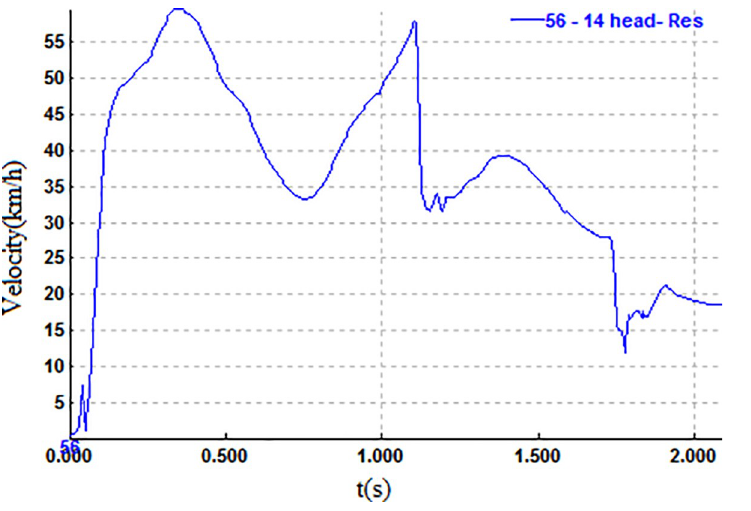
Fig 7. Speed curve of the pedestrian